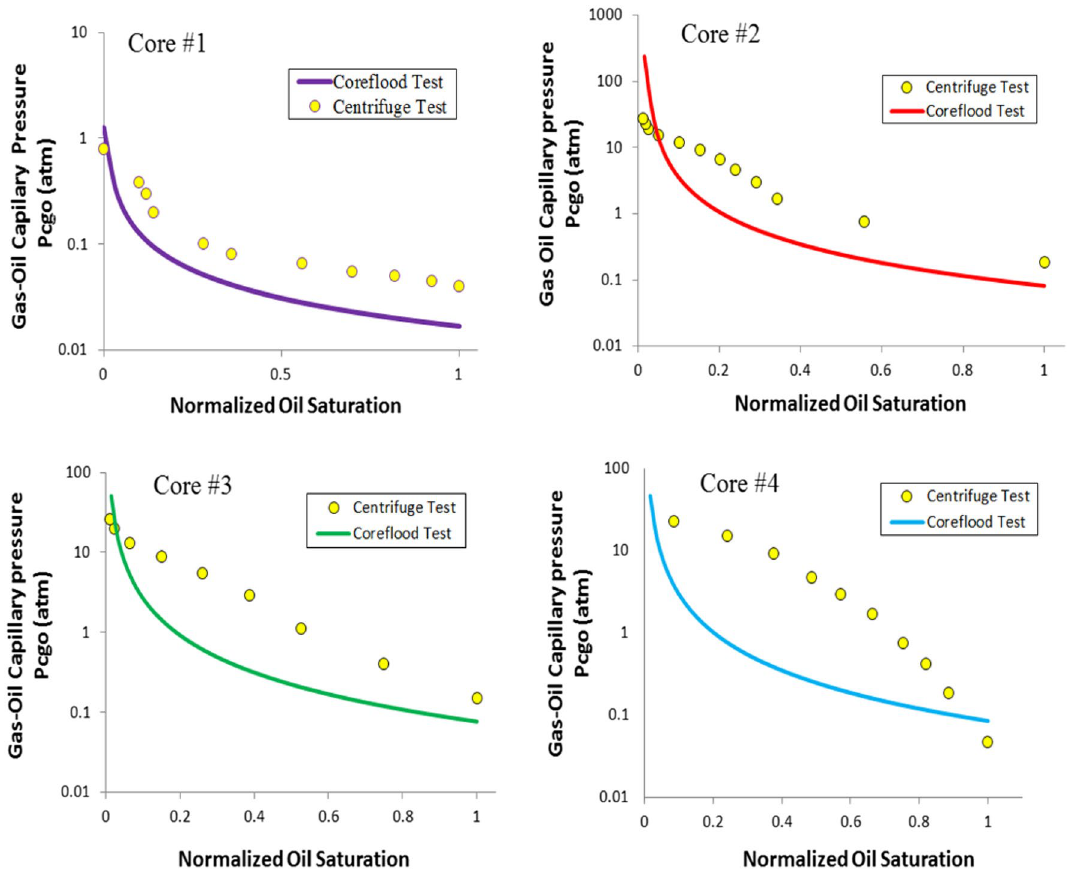
Fig. 11 Oil–gas capillary pressure versus normalized oil saturation obtained from the centrifuge test and those resulting from history matching (HM) of the gas injection tests Table 6 Parameters of the LET model and the Skjæveland model estimated using the ACO model in a gas injection process consider- ing capillary effects